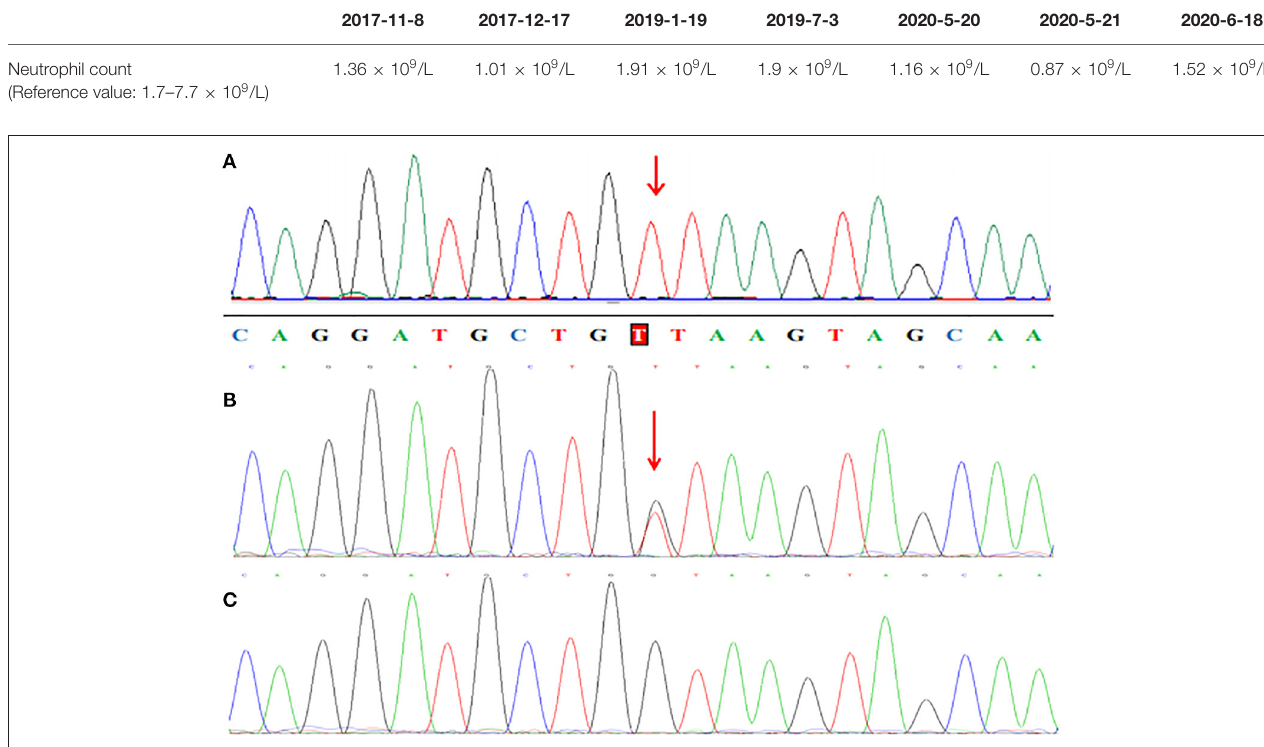
TABLE 2 | Neutrophil counts in different periods.